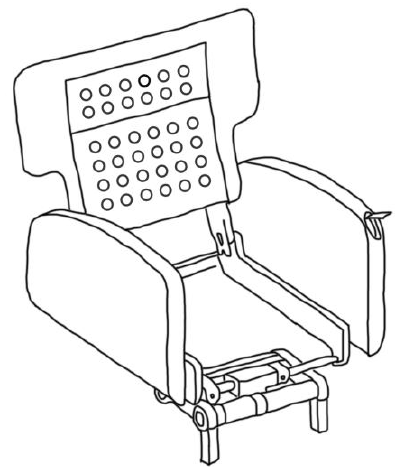
Figure 16. US Patent 8,376,462 B2 Aircraft seat with holes on the back [18].